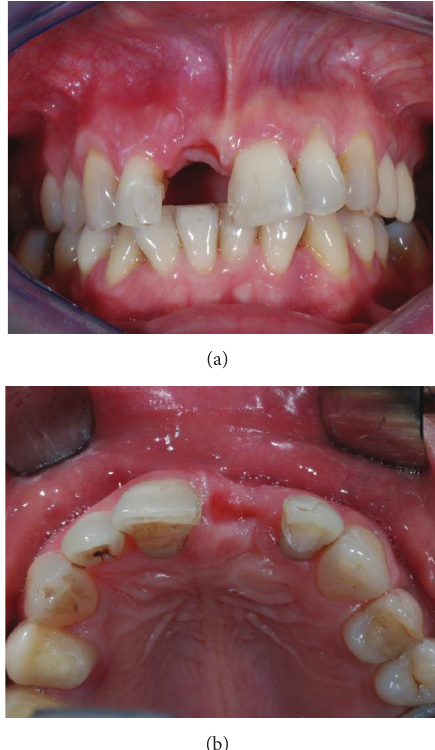
Figure 7: Frontal (a) and occlusal (b) views after six weeks of healing.